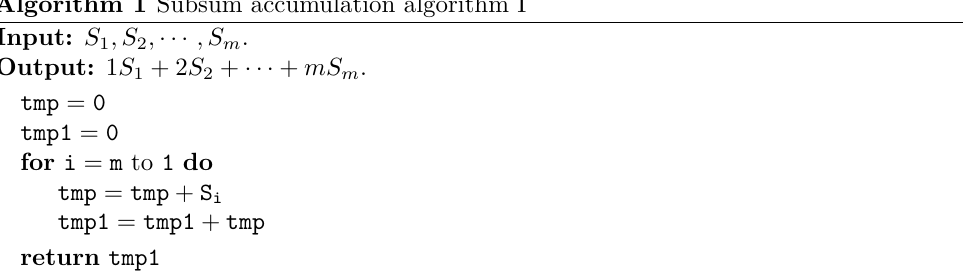
Algorithm 1 Subsum accumulation algorithm